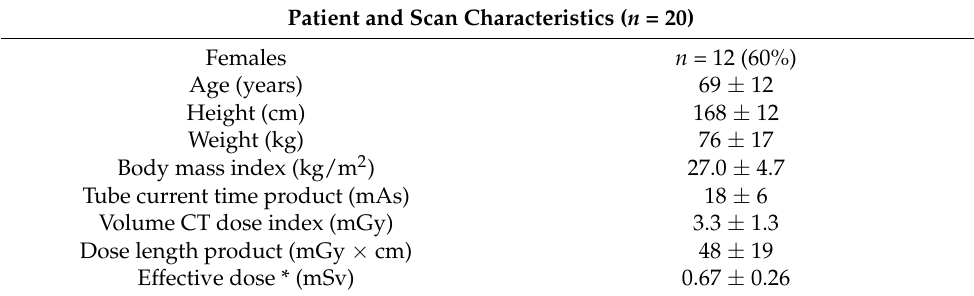
Table 1. Patient baseline and scan characteristics.